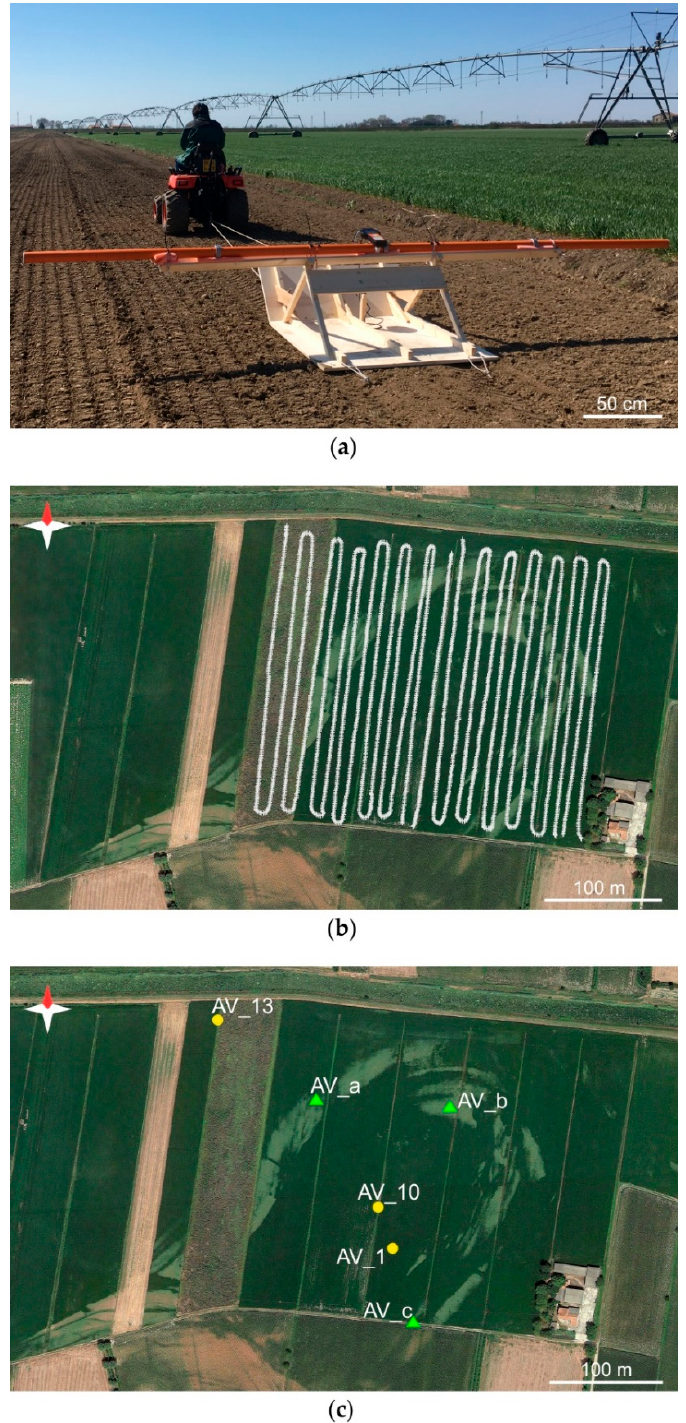
Figure 2. Methodologies. ( a – b ) Geophysical acquisition: ( a ) the electromagnetic tool on the wooden sledge dragged by a small tractor on the study field and ( b ) the survey path. ( c ) Position of the recovered cores. Yellow dots and green triangles indicate the hand auger core and the drilled cores with rotary technique, respectively.